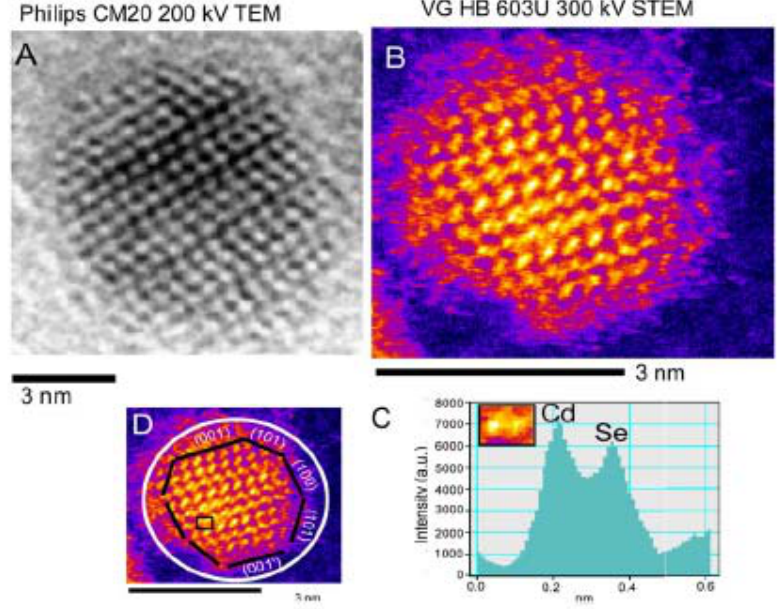
Figure 6. (A) High resolution transmission electron microscopic micrograph vs. (B) Z- contrast scanning transmission electron microscopic (STEM) micrograph of a CdSe Qdots. (C) STEM image shows mass distribution to determine a crystallite facet; (D) CdSe crystal facets are shown in STEM micrograph [reprinted from [98] with permission from